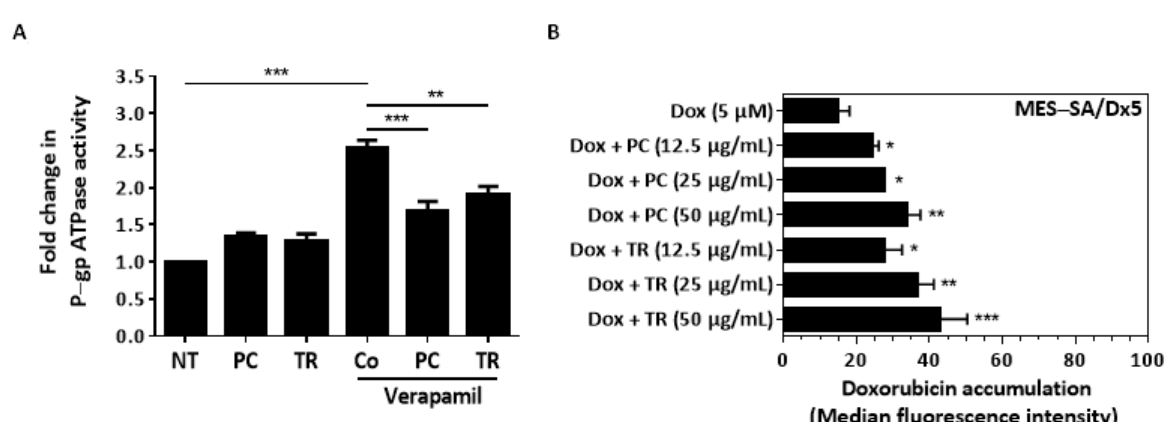
Figure 11. Pituranthos chloranthus (PC) and Teucrium ramosissimum Desf. (TR) extracts restore doxorubicin (Dox) sensitivity through a reduction in P-glycoprotein (P-gp)-mediated drug efflux. ( A ) Analysis of the effect of PC and TR alone or combined with verapamil on P-gp adenosine triphosphatase (ATPase) activity. Verapamil is used as a positive control by stimulating P-gp-mediated ATP hydrolysis. Since verapamil is a substrate for transport, PC and TR were tested to evaluate their capacity to reduce Pg-P activity by competing with verapamil. Drug-related P-gp ATPase activity is reported as a fold change relative to basal P-gp ATPase activity (untreated). The results are expressed as mean fold change ± Standard Error of the Mean (SEM) of one experiment performed in triplicate; p -values were determined by a one-way ANOVA followed by Tukey’s multiple comparison test. ** p < 0.01 and *** p < 0.001, with F value = 34.91. ( B ) Analysis of doxorubicin (Dox) uptake after a 1 h exposure of vehicle control (dimethyl sulfoxide, DMSO) or the PC and TR concentrations indicated, followed by incubation with 5 µM Dox at 37 °C for 6 h in MES-SA and MES-SA/Dx5 cells. Data are expressed as median of fluorescence intensity ± SEM of three independent experiments; p -values were determined by a one-way ANOVA followed by Tukey’s multiple comparison test. * p < 0.05, ** p < 0.01, and *** p < 0.001, with F value = 12.55.